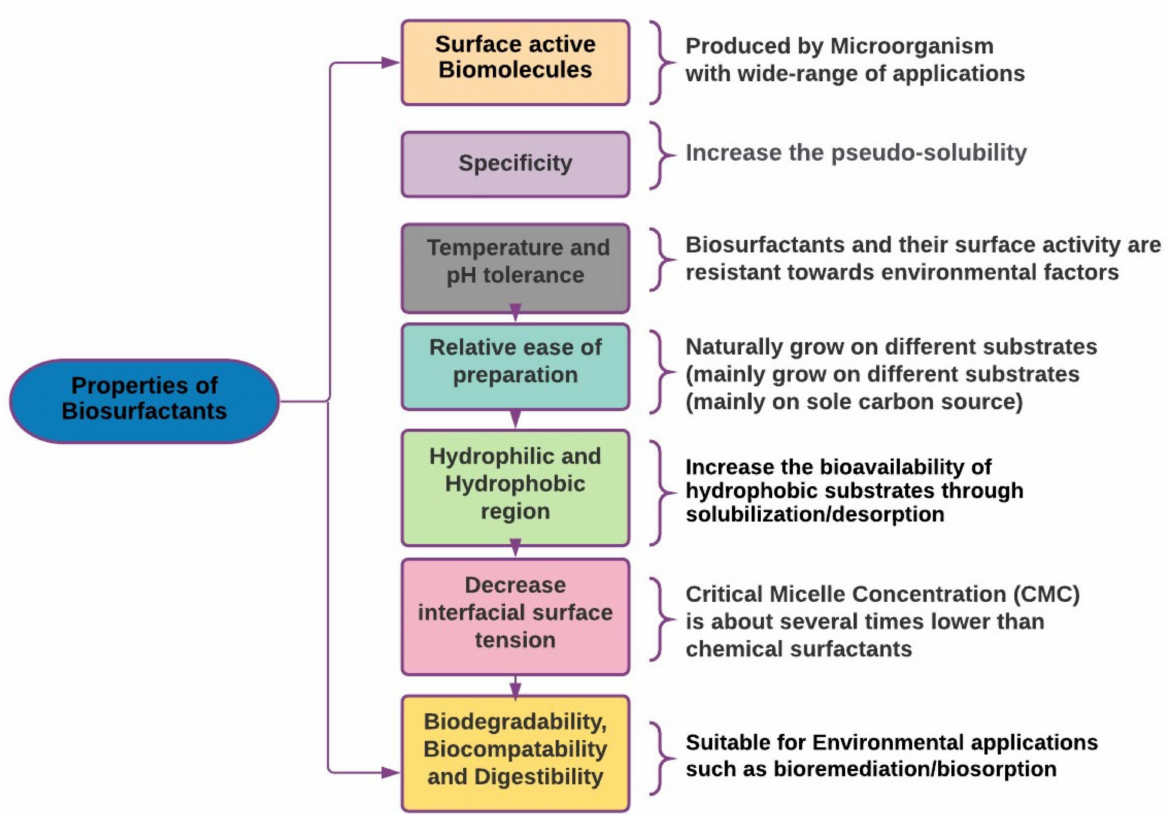
Figure 7. Properties of